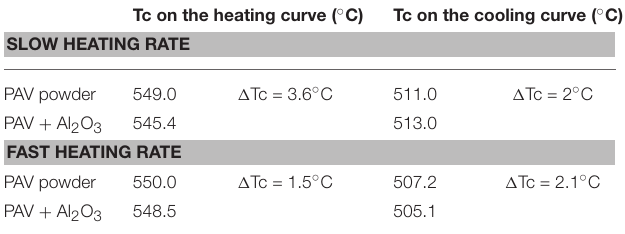
TABLE 2 | Comparison of the calculated Curie temperatures (Tc) for sample PAV using small sample size without supporting uplift of the material (powder PAV) and with uplift of the powder up to the thermocouple’s tip by using Al 2 O 3 powder. Tc on the heating curve ( ◦